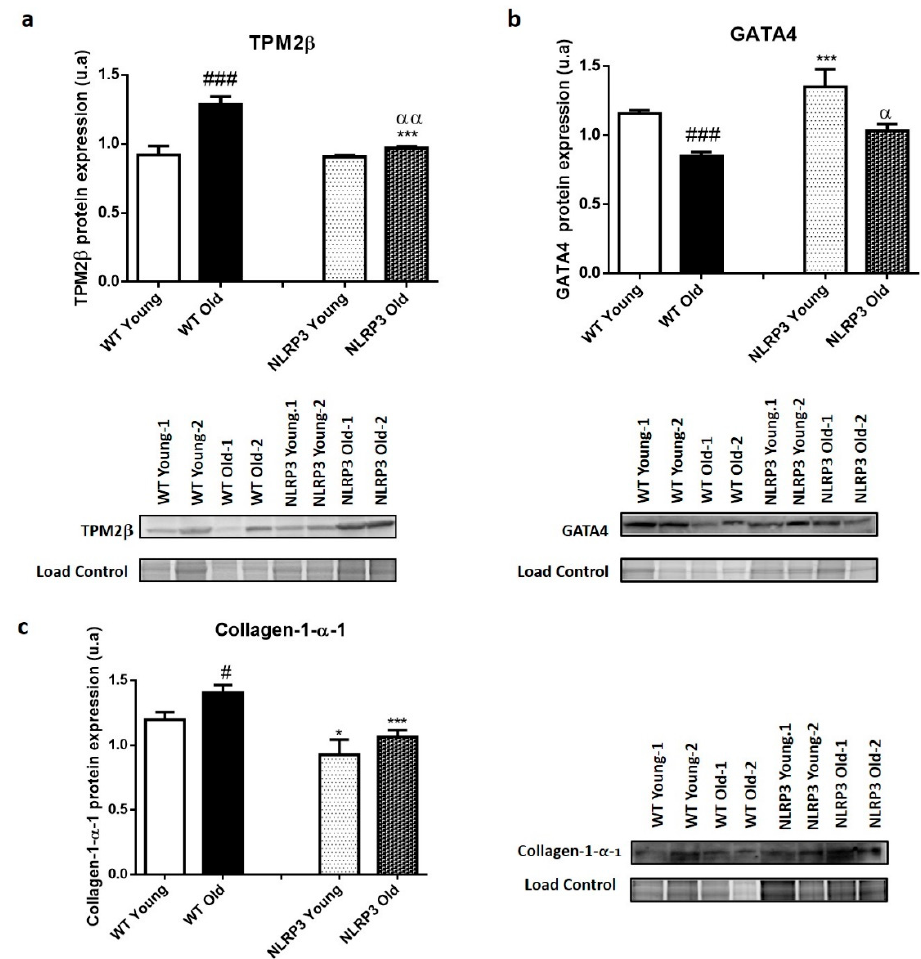
Figure 4. Protein expression levels of fibrotic markers in the liver tissue samples of WT and NLRP3 − / − mice. ( a ) TPM2 β ( b ) GATA4 ( c ) Collagen-1- α -1 (COL1 α 1). All data are shown as the means ± SEM ( n = 8). * p ≤ 0.05/*** p ≤ 0.001 (WT Young/Old vs. NLRP3 Young/Old); # p ≤ 0.05/### p ≤ 0.001 (WT Young vs. WT old); α p ≤ 0.05/ αα p ≤ 0.01 (NLRP3 Young vs. NLRP3 old).